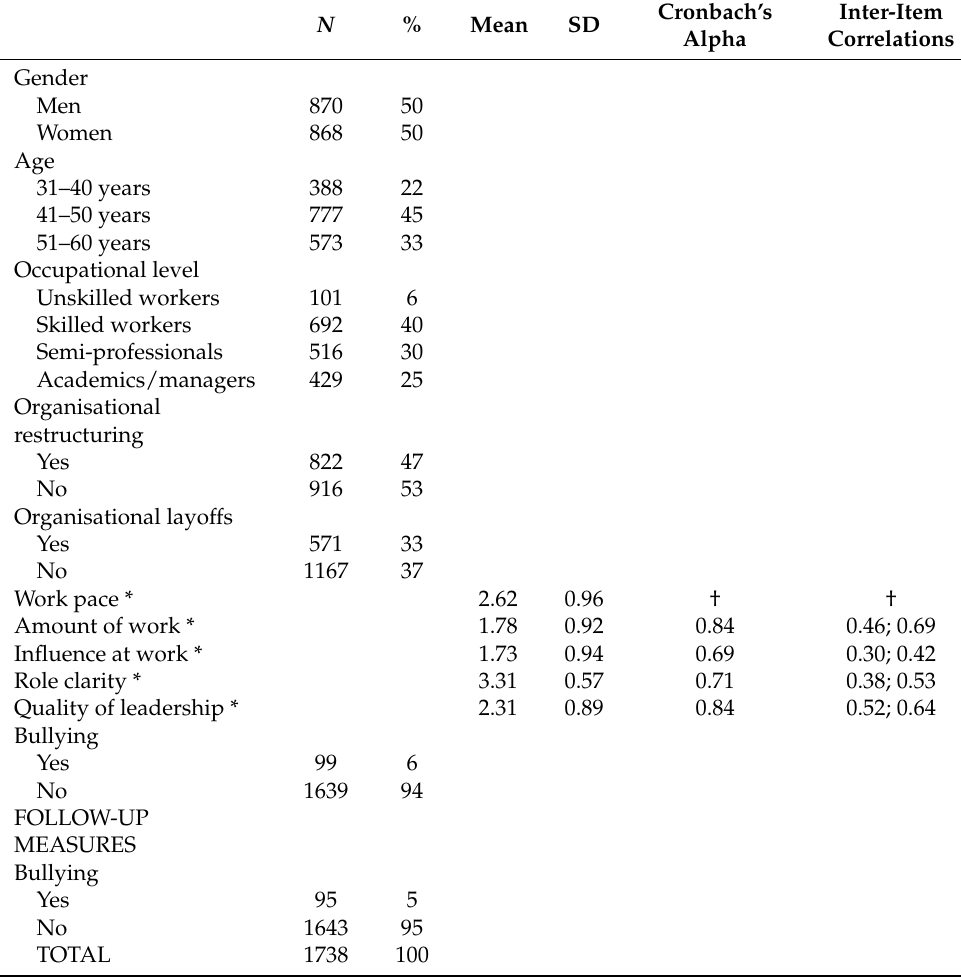
Table 1. Characteristics of the sample at baseline ( N =